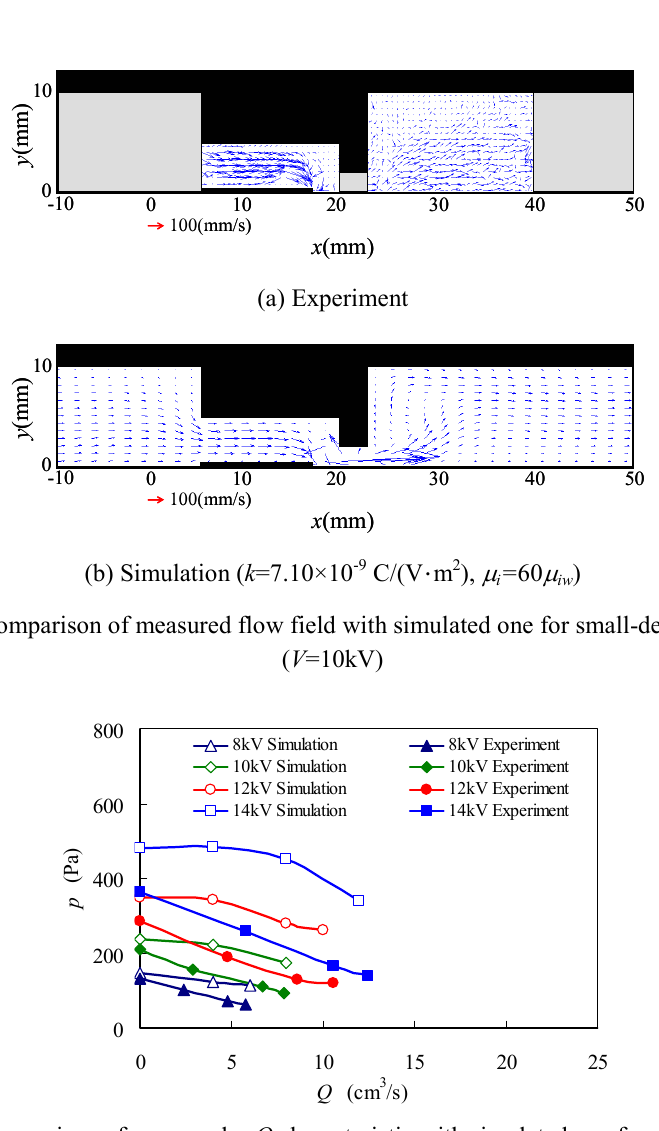
for simulation) = 60 µ i iw